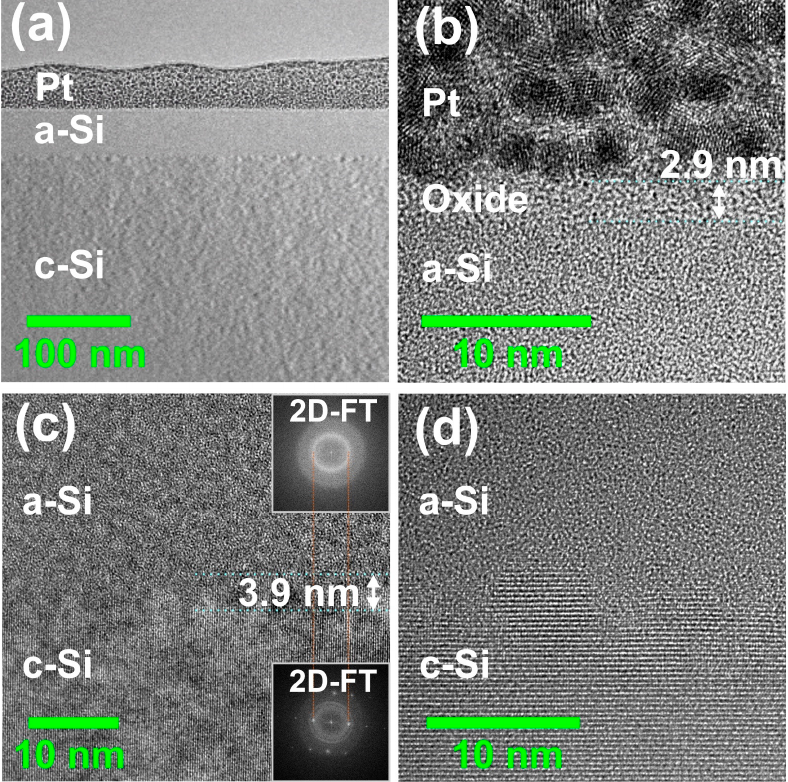
Figure 6. TEM images of an fs-laser-amorphized spot in cross-section ( E p = 12 µJ / φ 0 = 0.24 J/cm 2 ) on c-Si<111> taken at the position marked by the red square in Figure 1. ( a ) Overview; ( b ) high-resolution image of native oxide layer between the Pt capping layer and the a-Si layer; ( c , d ) high-resolution images of the a-Si/c-Si interface. Note the different magnifications. The insets in ( c ) are two-dimensional fast Fourier transforms (2D-FTs) of high-resolution transmission electron microscopy (HRTEM) images of the a-Si and c-Si regions, respectively.